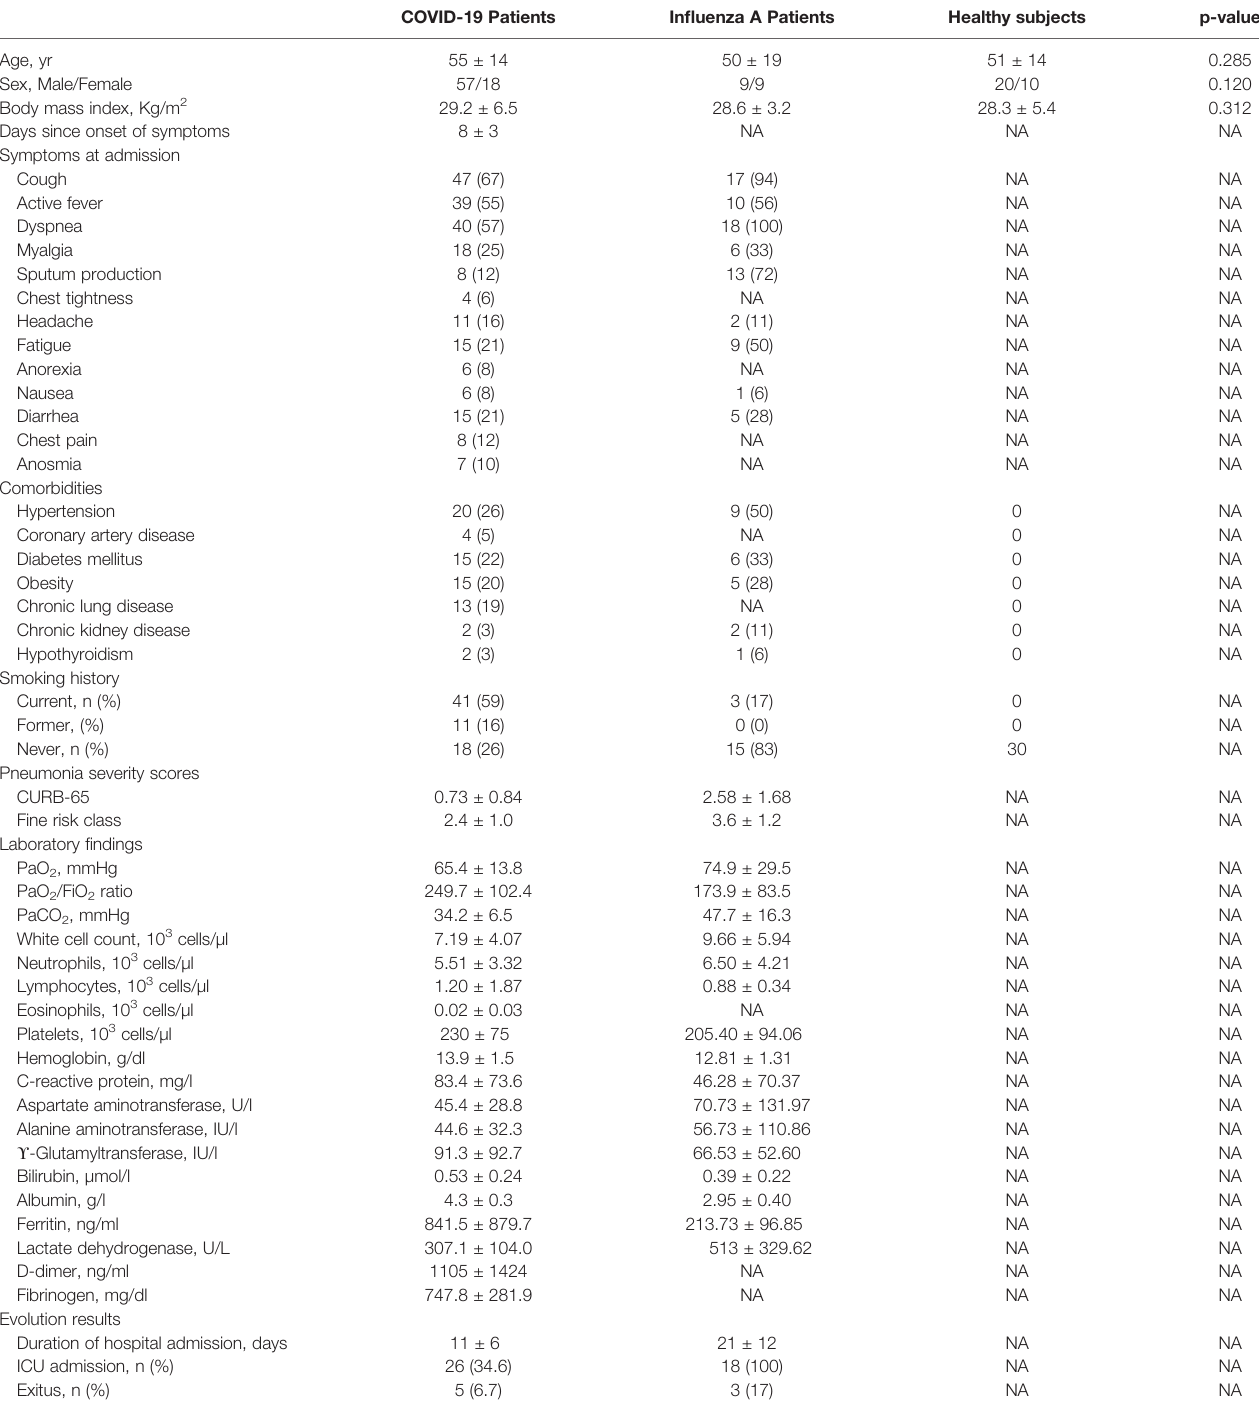
TABLE 1 | General characteristics of the study